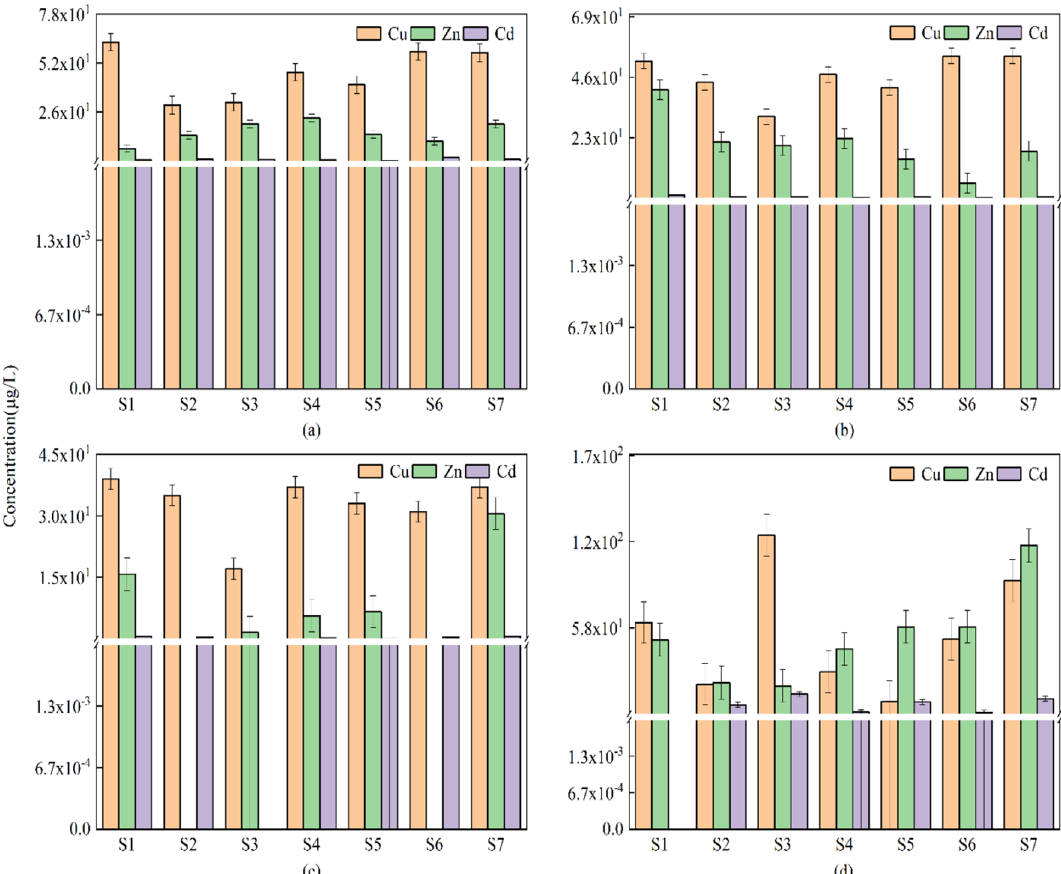
Figure 3. Spatial and temporal distribution characteristics of heavy metals in surface water. ( a – d ) are the histograms of heavy metal concentrations in the surface water of Yitong River basin in June, August, October and December,